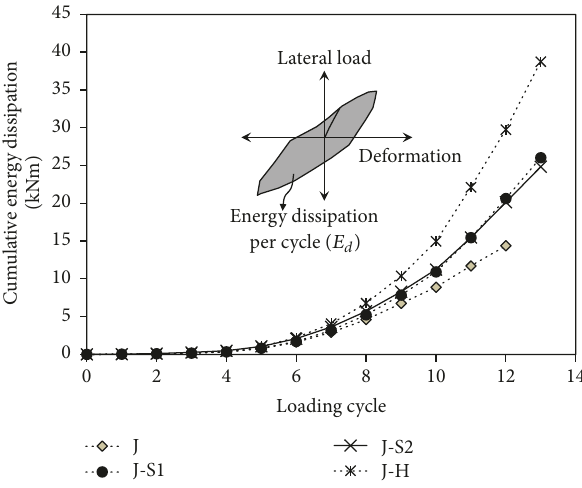
Figure 12: Cumulative dissipated energy of test